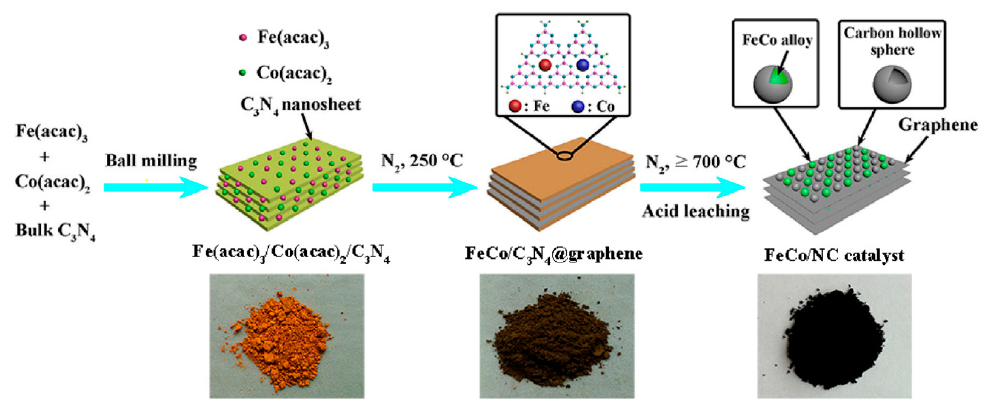
Figure 2. Schematic illustration synthesis process of FeCo / NC catalysts from Fe(acac) 2 , Co(acac) 2 , and bulk C 3 N 4 , reproduced with permission from [27]. Copyright Springer nature, 2017.